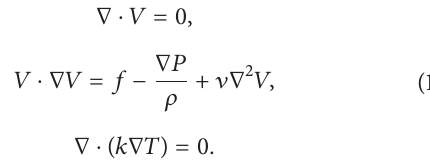
∘ . A good agreement is observed.